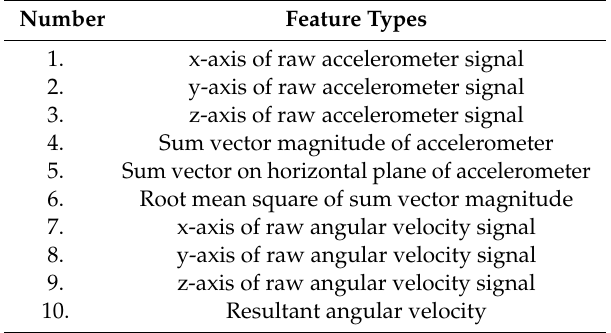
Table 1. Types of features were extracted from inertial measurement unit sensor